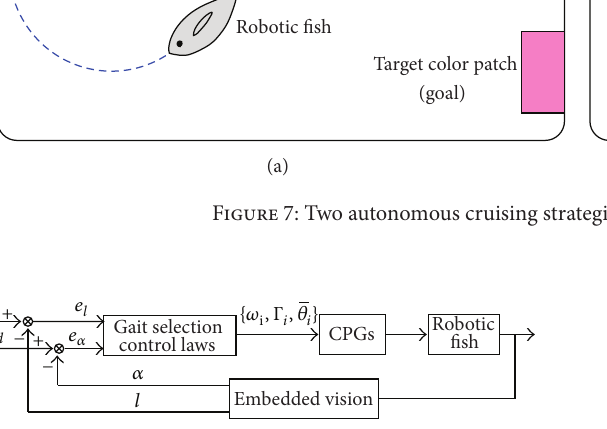
Figure 8: Block diagram of visual feedback coupled closed-loop control in 2D swimming.